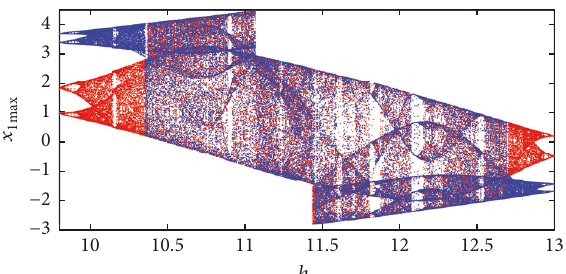
Figure 7: Bifurcation of the TDNHPS with parameter 𝜔 𝜏 .